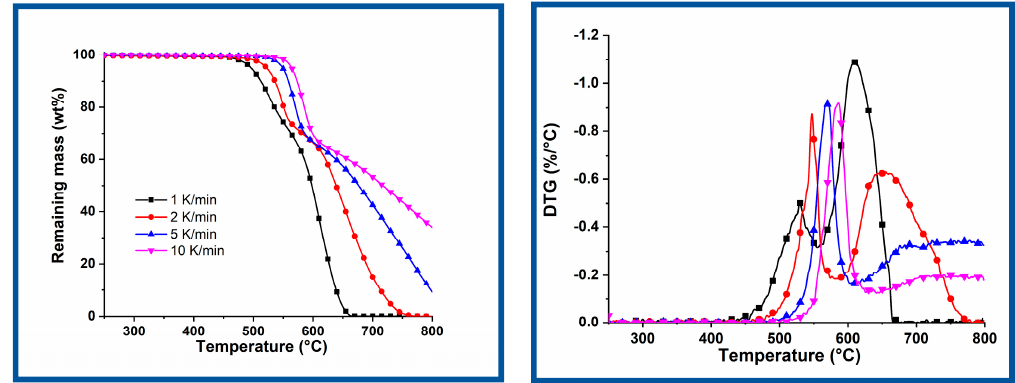
Figure 8. TG ( left ) and the corresponding DTG ( right ) curve of PEEK at 1 (black), 2 (red), 5 (blue), and 10 K / min (magenta), under 2%